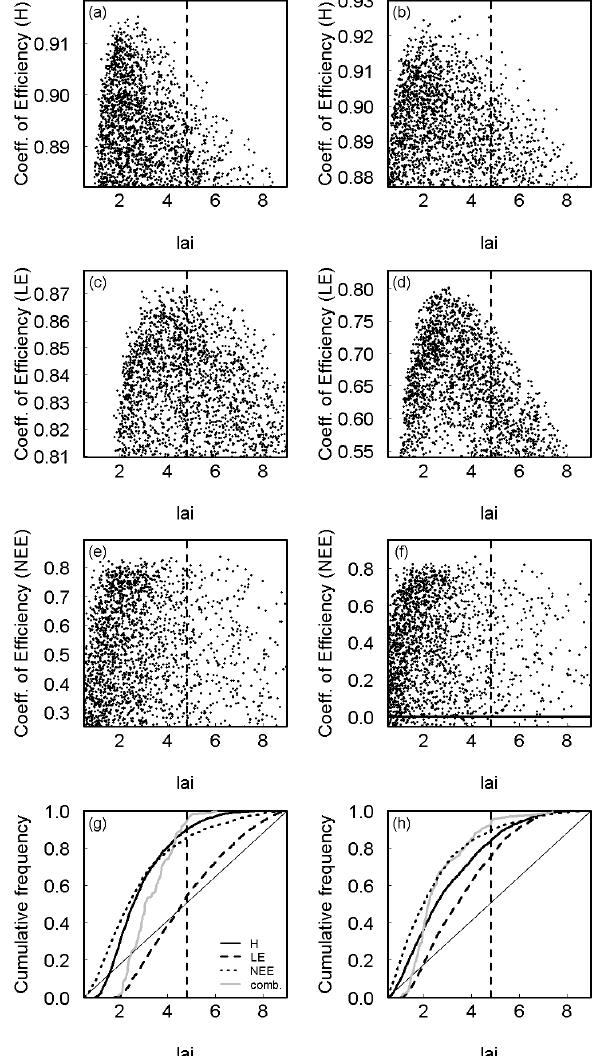
Fig. 3. Sensitivity graphs showing the range of the single-objective coefficients of efficiency for the best 10% parameter sets (left: IOP-1, right: IOP-2) for the sensible heat flux, H, (a) and (b) , the latent heat flux, LE, (c) and (d) , and the NEE, (e) and (f) , across the range of the leaf area index, lai [m 2 m − 2 ]. The vertical dashed line denotes the reference parameter value. Cumulative frequencies are plotted in (g) and (h) for the three fluxes as well as for the combined likelihood measure with the diagonal solid line showing a uniform parameter distribution for comparison.